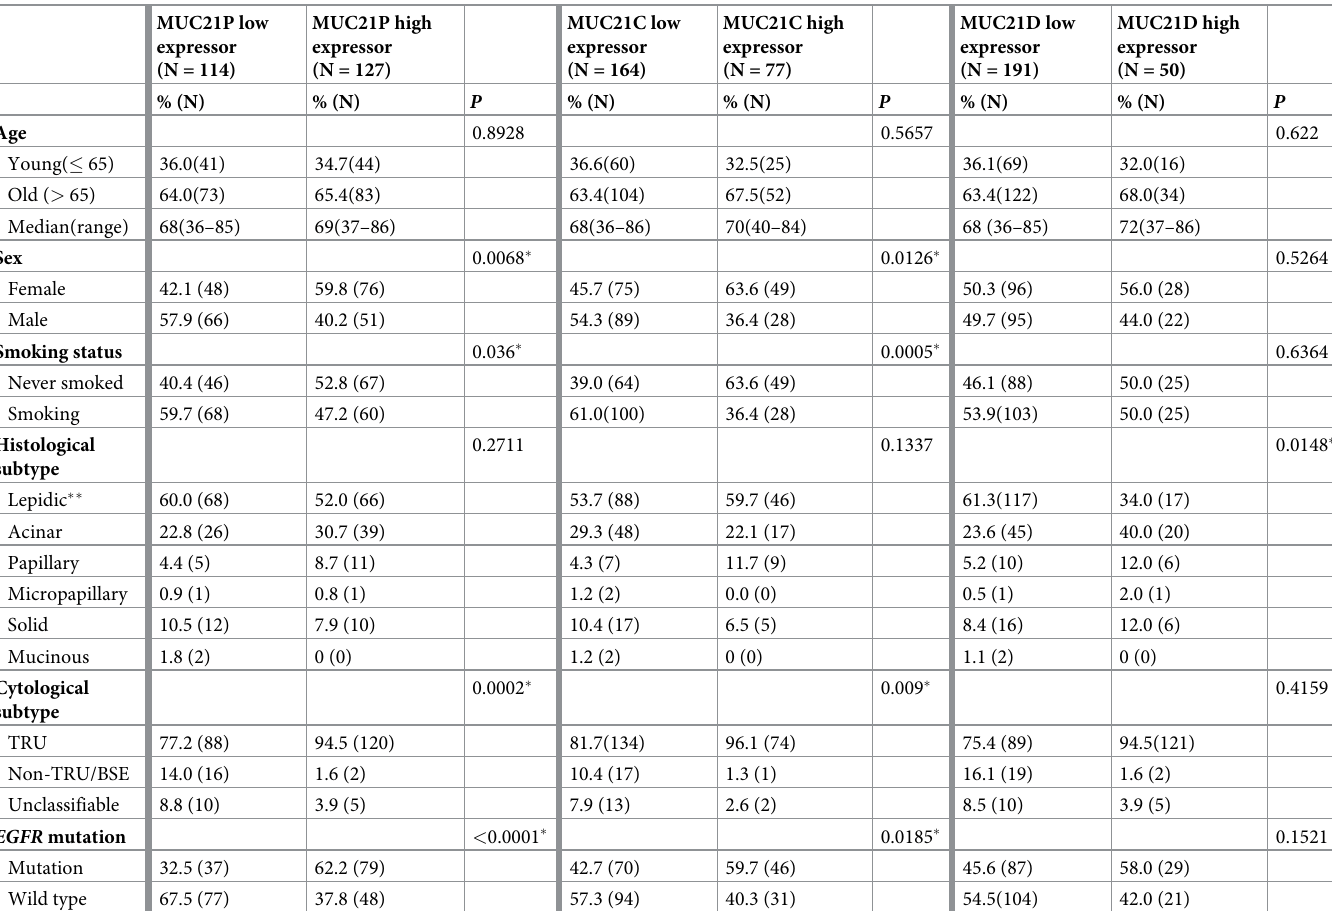
Table 1. Relationships between MUC21 expression and clinicopathological factors in lung